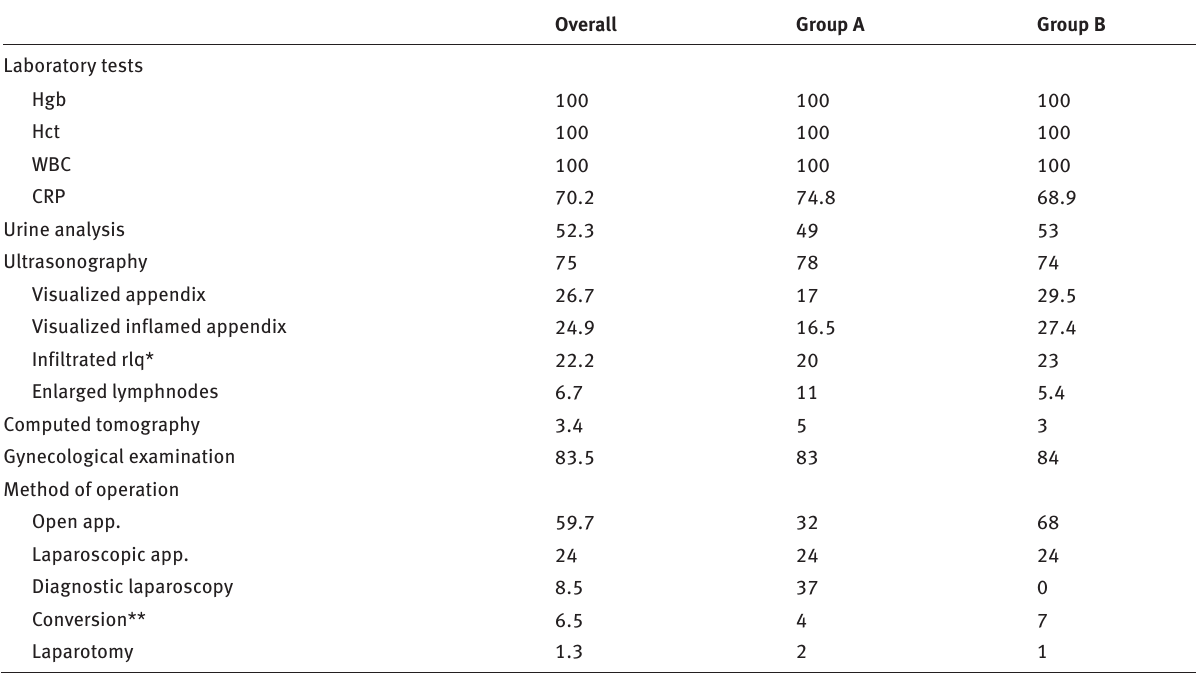
Table 2: Percentages (%) of laboratory tests, investigations and methods of operation overall and between groups